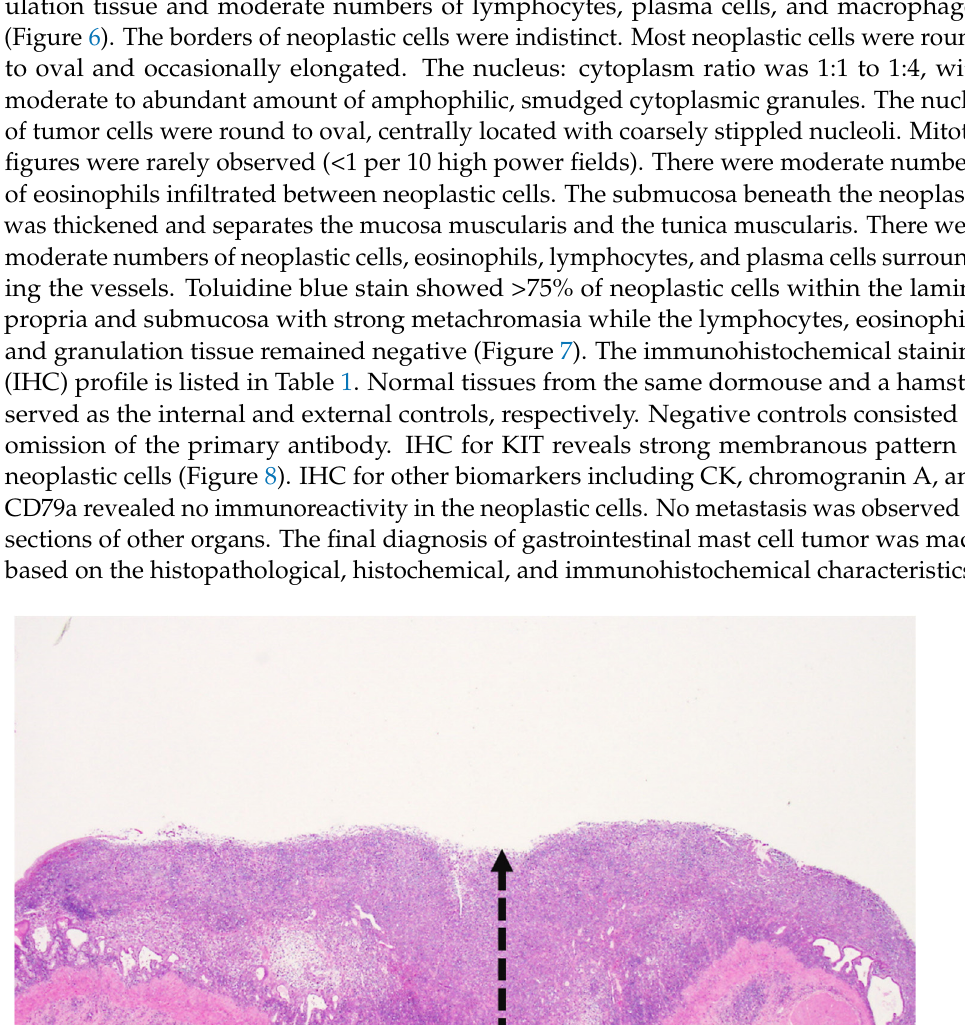
Figure 6. Gastric mast cell tumor, African dormouse, Hematoxylin and eosin. In the lamina propria, the tumor cells in sheet or cord patterns are mildly polymorphic (arrows) and are admixed with moderate number of eosinophils (arrowheads) and plasma cells (hollow arrows) (400×). There are amphophilic granules within the cytoplasm of neoplastic cells (inset A ) (1000×). These features can also be observed in normal mucosal mast cells (MMCs) in the small intestine (inset B ) (1000×) .